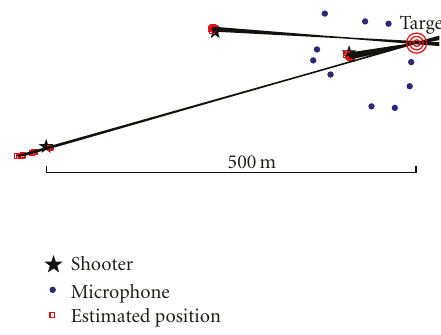
Figure 8: Estimated shooting directions. The relatively slow pistol ammunition is